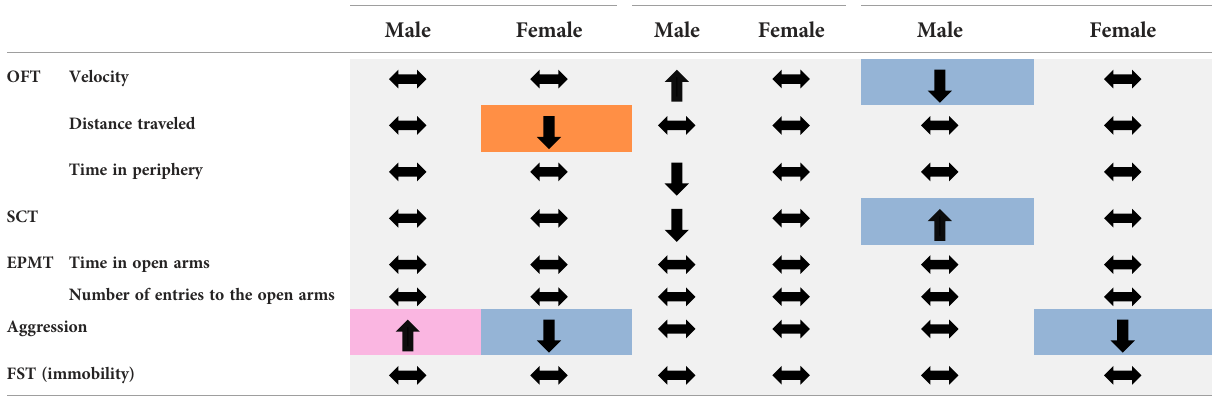
TABLE 1 Effect of MTK on behavior.